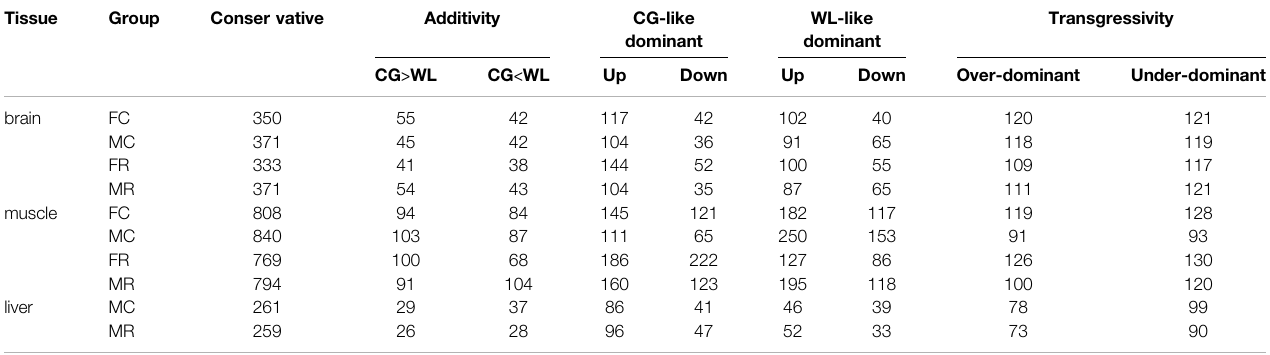
TABLE 1 | Summary statistics for splicing patterns in reciprocal crosses among tissues. Tissue